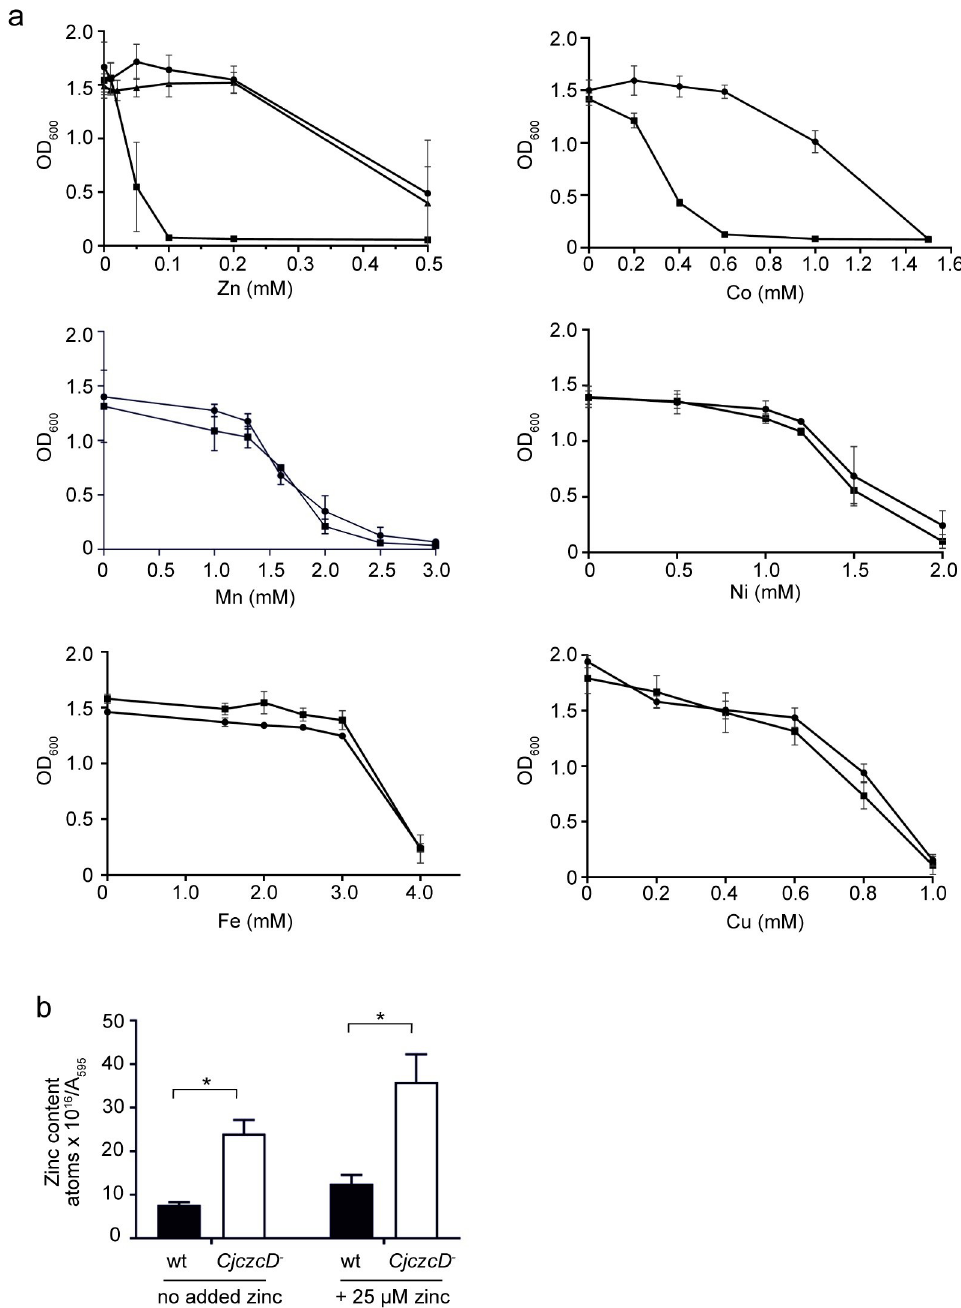
Fig 3. CzcD is a Zn(II) exporter and Zn(II)/Co(II) resistance determinant. a. C . jejuni NCTC 11168 (circles), Cj czcD - (squares) and the genetically complemented Cj czcD + strain (triangles) were grown for 24 hours at 37˚C in MH broth from a starting OD 600 of 0.05 with varying concentrations of metals and the OD 600 measured. For the zinc experiment, data for all three strains are presented whilst for other metals only the wild type and Cj czcD - strain are included. Data points are the mean of three biological repeats, each with three technical repeats and error bars represent standard error of the biological repeats. b. Cellular Zn(II) content of C . jejuni NCTC 11168 (wt) and the Cj czcD - strain was measured by ICP-MS. Cells were grown for 24 hours in MH broth with and without 25 μ M Zn(II) supplementation as indicated and the Zn(II) content of mid logarithmic phase cells measured. Data are the mean of three biological replicates with standard error of the mean indicated. The � symbol indicates a p value of < 0.05 from a two way ANOVA test.